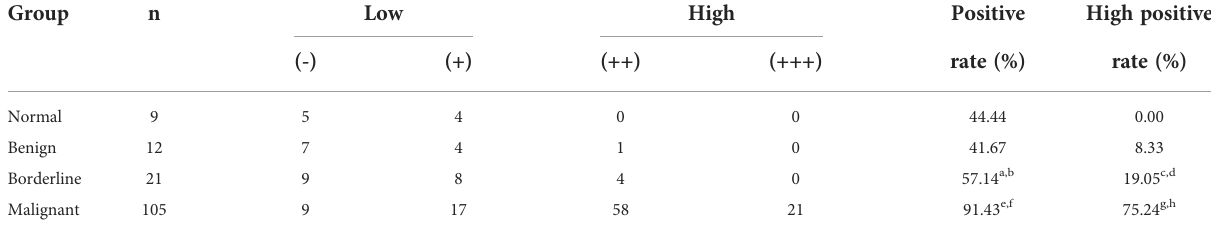
TABLE 1 Expression of MCP-4 in different types of ovarian tissue.